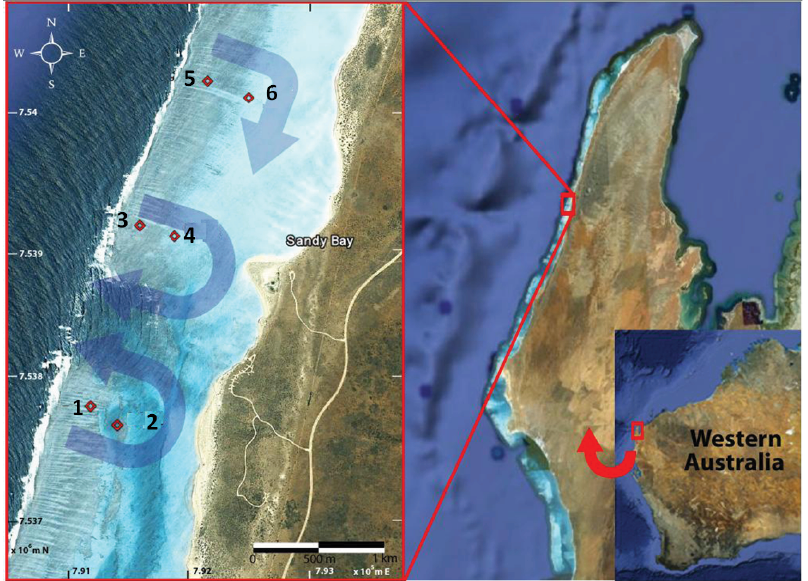
Figure 1. Map of study region and sampling stations (depicted by red diamonds and numbers). Superimposed blue arrows show the characteristic flow pattern across the reef flat and around the lagoon (as described by Lowe et al. 2008). Satellite imagery: Google Earth, 2010.